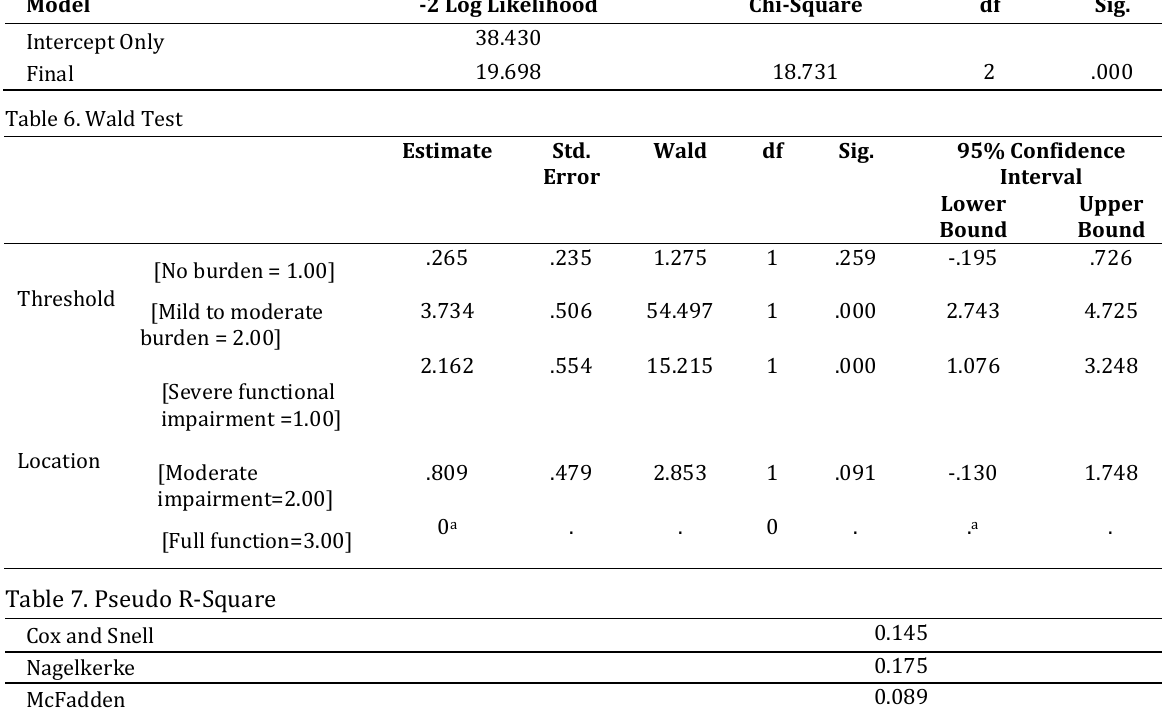
Table 5. Model Fitting Information Model